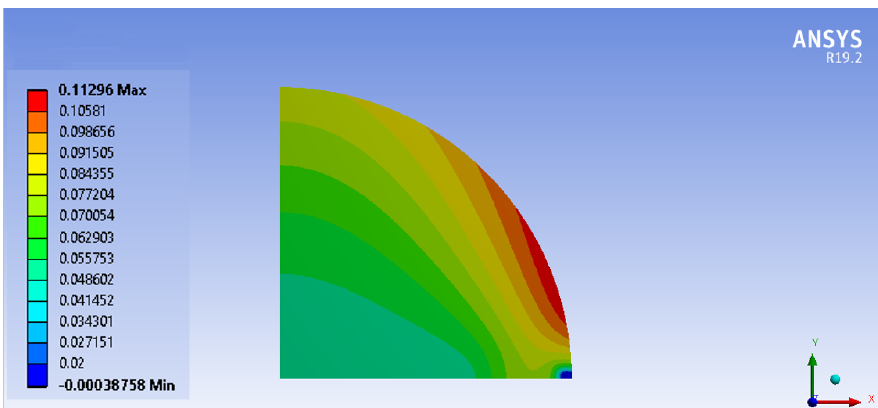
Figure 20. Out-of-plane displacements (in millimeters) after a complete thermo-mechanical bond- ing cycle.